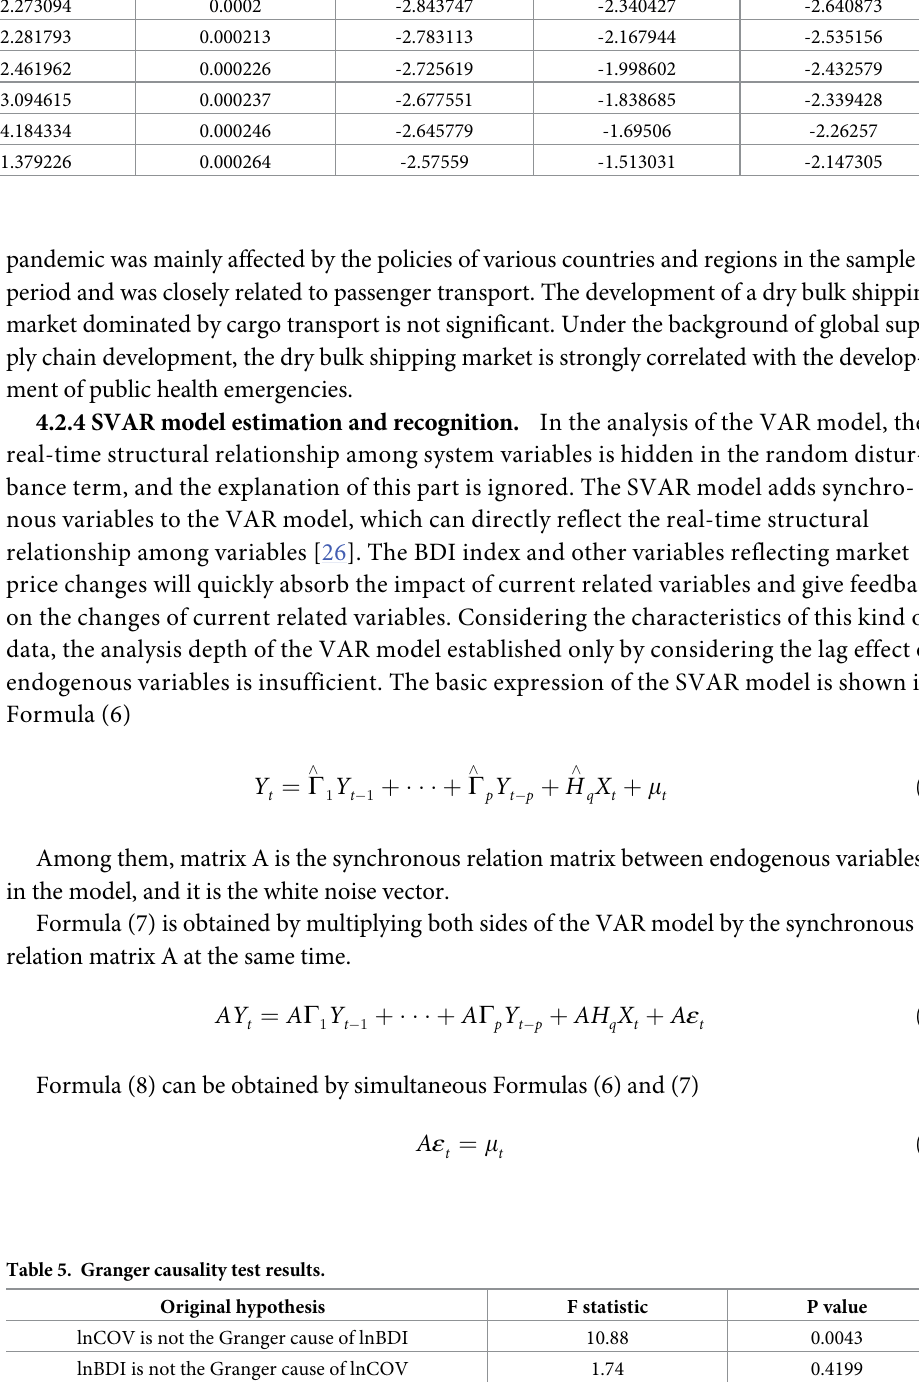
Table 5. Granger causality test